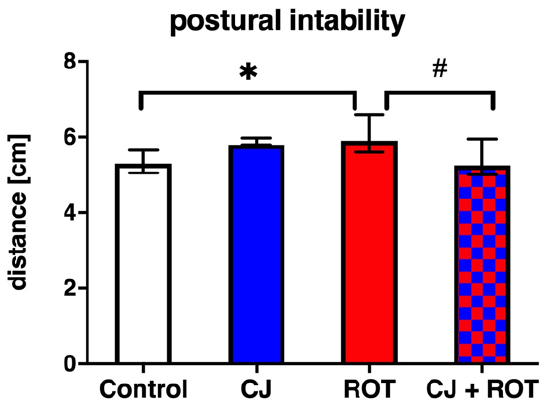
Figure 5. Effect of cranberry juice (CJ) treatment on postural instability in rotenone (ROT)-injected rats. Data are presented as median (bars) and interquartile range (whiskers) of eight rats per group and analyzed using Kruskal-Wallis followed by Dunn’s multiple comparisons test. * p < 0.05 vs. Control. # p < 0.05 vs. ROT.